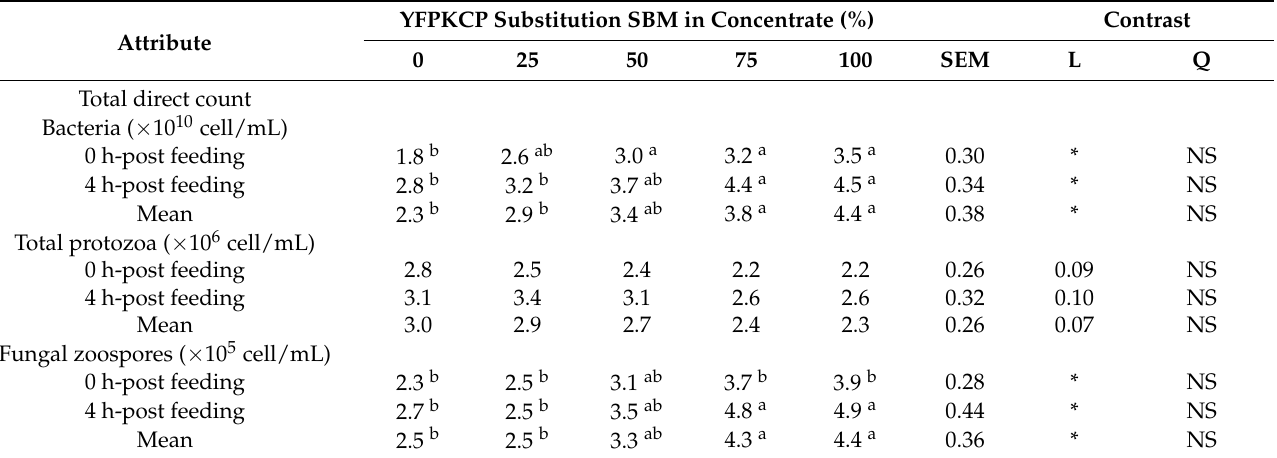
Table 6. Diversity of rumen microorganisms in goats fed a concentrate diet comprising fermented palm kernel